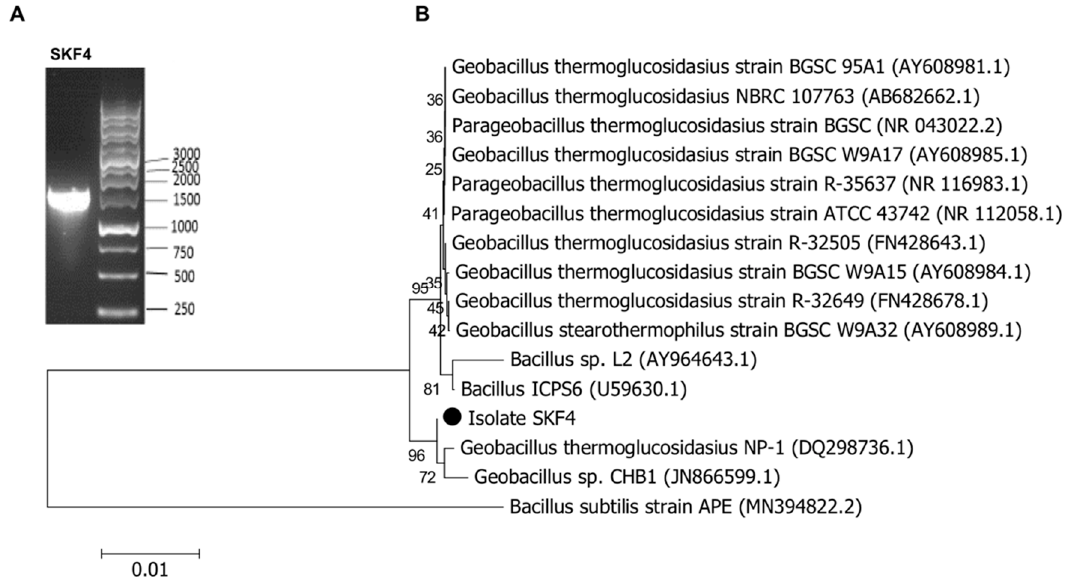
Figure 3. ( A ) The agarose gel electrophoresis of 16S rRNA amplified from the genomic DNA of the isolate SKF4 using 27F and 1492R primers. ( B ) Phylogenetic tree of Geobacillus thermoglucosidasius SKF4. The tree is drawn to scale, with branch lengths in the same units as those of the evolutionary distances used to infer the phylogenetic tree. The analysis involved 15 nucleotide sequences of some closely related species. Bacillus subtillis was placed as an outer group.